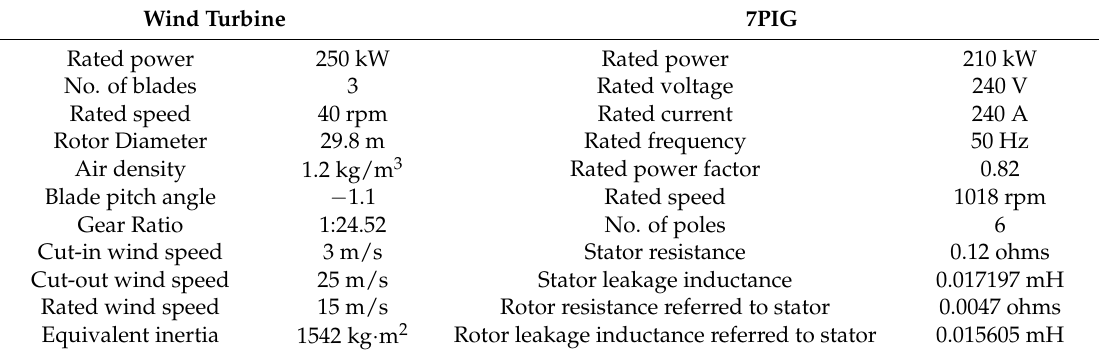
Table A1. Wind Turbine and Seven Phase Induction Generator Parameters taken for